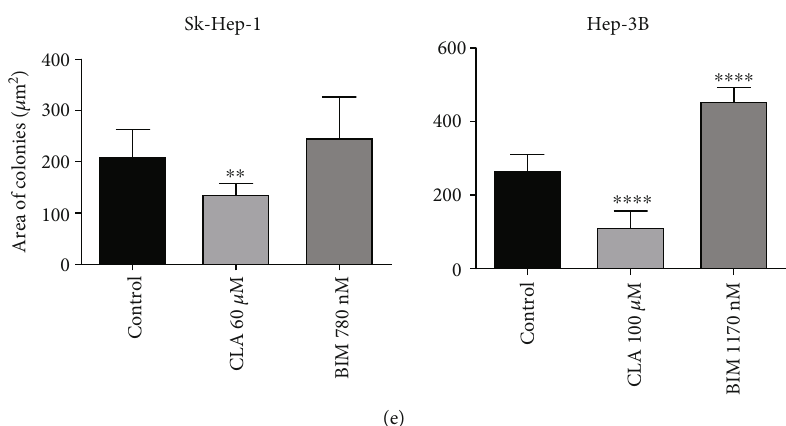
Figure 1: The proliferation rate and colony formation capacity of Hep-3B and Sk-Hep-1 cells after treatment with CLA or BIM for 48 h. (a) Sk-Hep-1 and Hep-3B cells which were treated with di ff erent concentrations of CLA (30, 60, 80, and 100 μ M) showed a signi fi cant reduction in proliferation rate in a dose-dependent manner as compared to the control groups ( n = 3 ). Also the proliferation rates in both cell lines increased signi fi cantly after treatment with BIM. (b), (c), (d), (e) CLA treatment reduced the number of colonies and total area of them in both cell lines compared to the control groups. Also, the number and total area of colonies in BIM treated groups increased signi fi cantly compared to the control groups in both cell lines. Data are presented as the mean ± SD , n = 3 ( ∗ p < 0 : 05 , ∗∗ p < 0 : 01 , ∗∗∗ p < 0 : 001 , and ∗∗∗∗ p < 0 : 0001